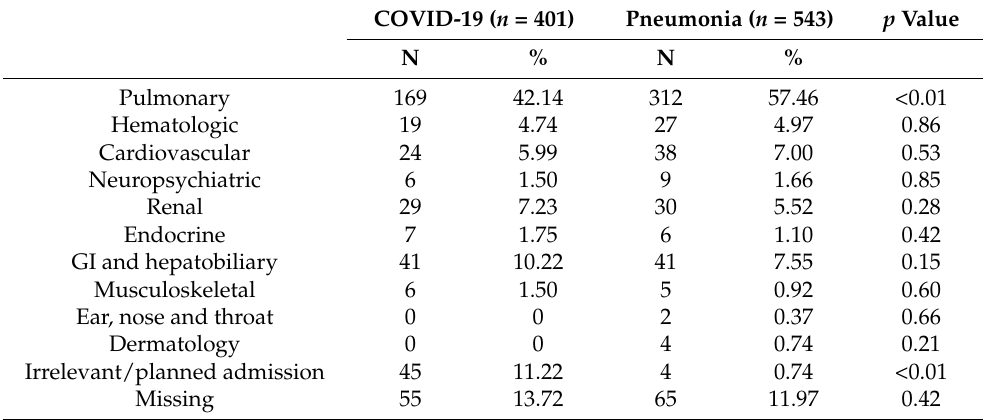
Table 4. Reasons for 30-day hospital readmission among discharged patients with COVID-19 and pneumonia, NGHA, Saudi